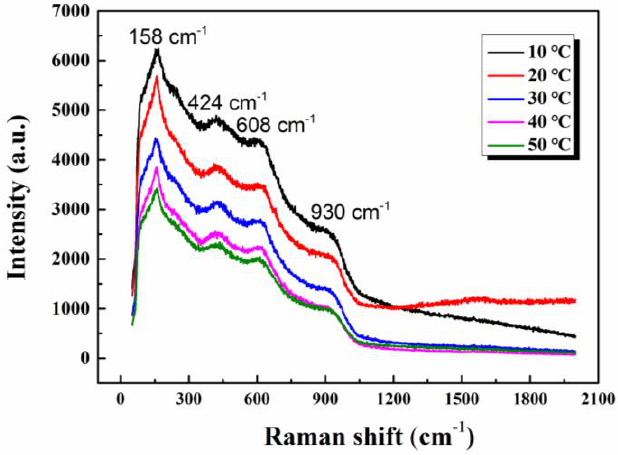
Figure 7. Raman spectra of composite anodic films fabricated at different temperatures.